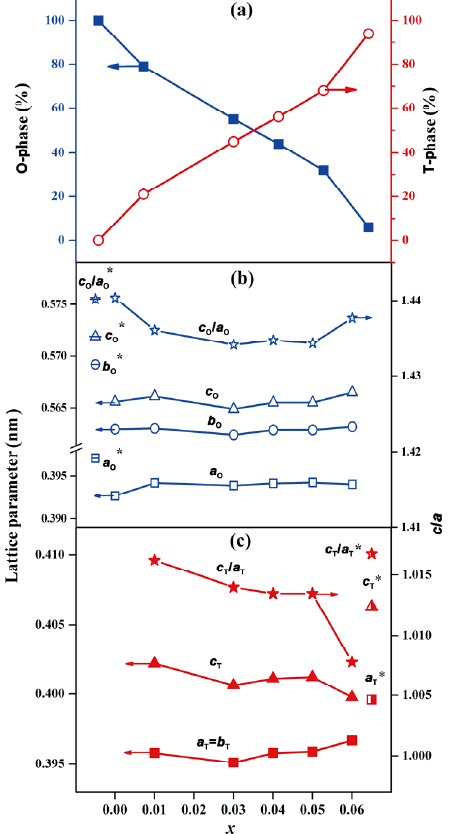
Fig. 4 Phase composition percent and lattice parameters calculated by simulating with Gaussian–Lorentzian curve-fitting method. Data from PDF index are marked with “*”. (a) Area percent of O phase and T phase peak; (b) lattice parameters and c / a of O phase; (c) lattice parameters and c / a of T phase.